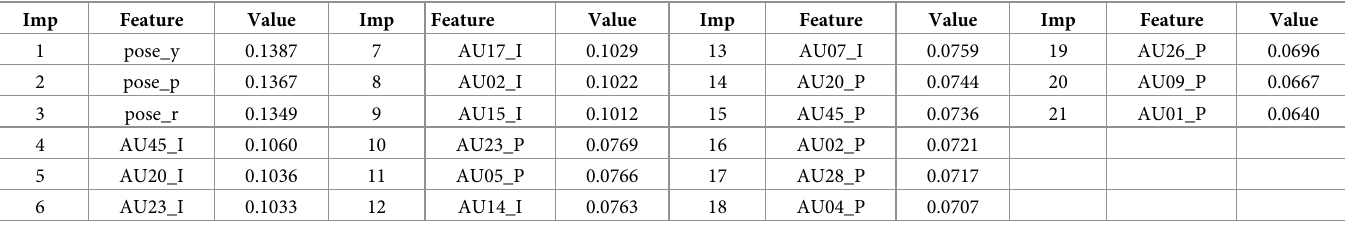
Table 9. Features importance for the FF4 by Using RFc